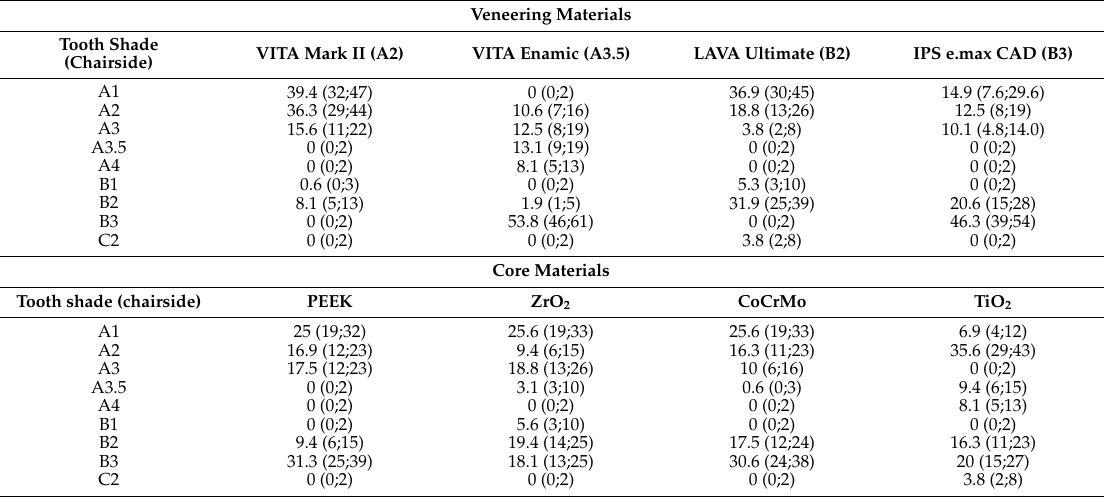
Table 3. Relative frequency (%) and 95% CI of the measured VITA EasyShade parameters of all assemblies between core and veneering material, regardless of the veneering thickness and core materials (left)/veneering materials (right).